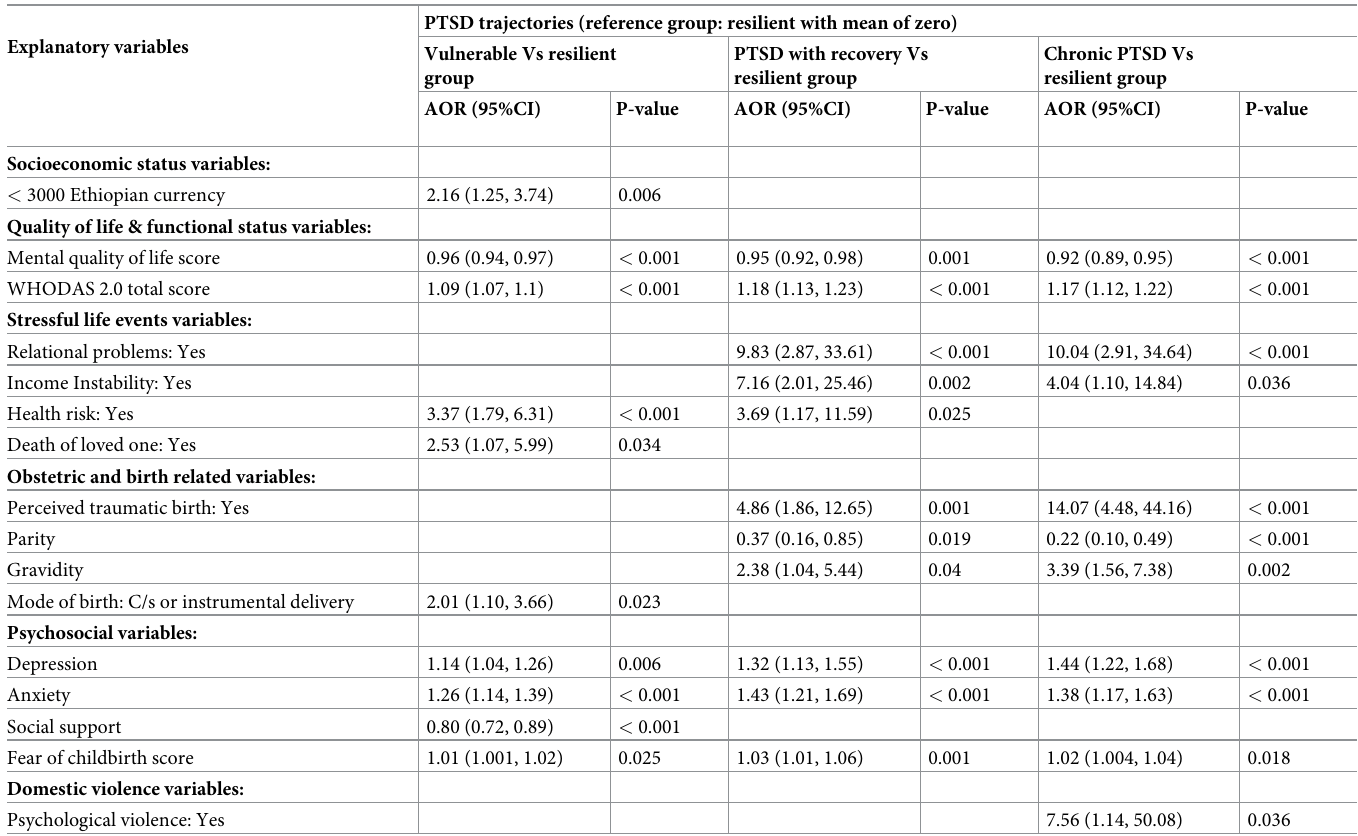
Table 4. Significant predictors of PTSD trajectories among postpartum women, Northwest Ethiopia, 2021. Explanatory